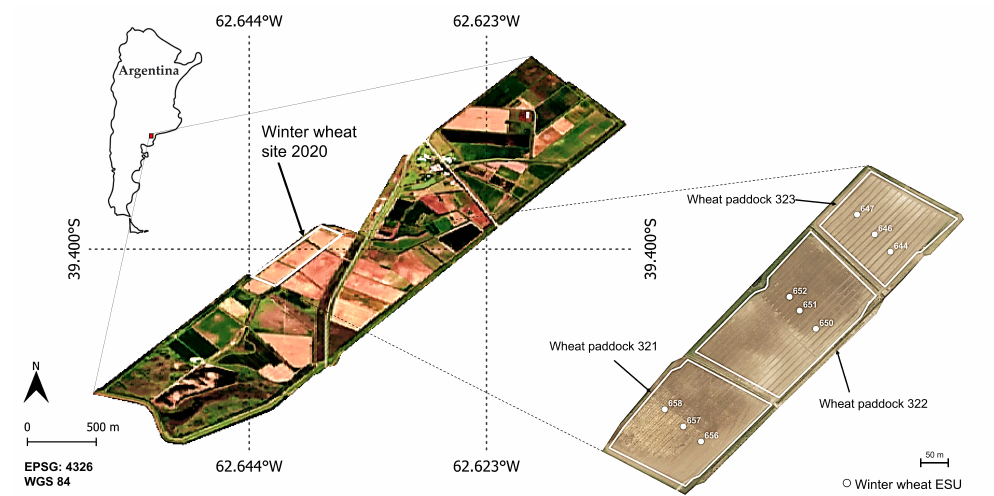
Figure 1. Test fields of irrigated winter wheat in the study site. True color S2 image of 27 December 2020, partly adapted from [63]. Reference system: WGS84 (EPSG